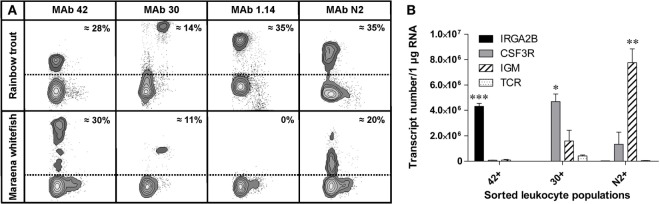
(A) Comparison of the staining patterns of the cross-reactive monoclonal antibodies detecting peripheral blood leukocytes of rainbow trout (upper panel) and maraena whitefish (lower panel). PBLs were stained with monoclonal antibodies MAb 42 (thrombocytes), MAb 30 (myeloid cells), MAb 1.14 (B cells; heavy chain of immunoglobulin), and MAb N2 (B cells; light chain). The proportion of each cell population is expressed as the percentage of the number of stained PBLs. (B) The copy number of the leukocyte marker genes IRGA2B/CD41 (black bars), CSG3R/GCSFR (gray), IGM (hatched), and TCR (dotted) in immune cell populations magnetically sorted with MAb 42, MAb 30, and MAb N2 as indicated. Graphs depict the mean values + SEM (error bars). Transcript numbers significantly different from the other markers are indicated with asterisks, as evaluated by one-way analysis of variance (*p = 0.03; **p = 0.01; ***p = 0.0001).